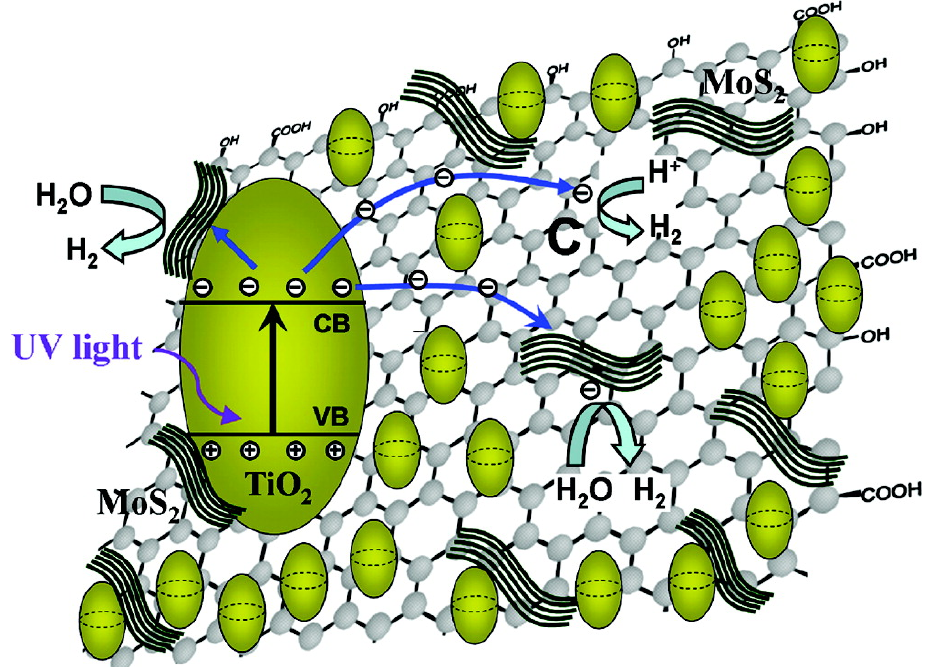
Figure 7. Schematic illustration of the charge transfer and proposed mechanism of electron transfer in TiO 2 /MoS 2 /graphene composites. Reprinted with permission from Ref. [18]. Copyright 2012 American Chemical Society.